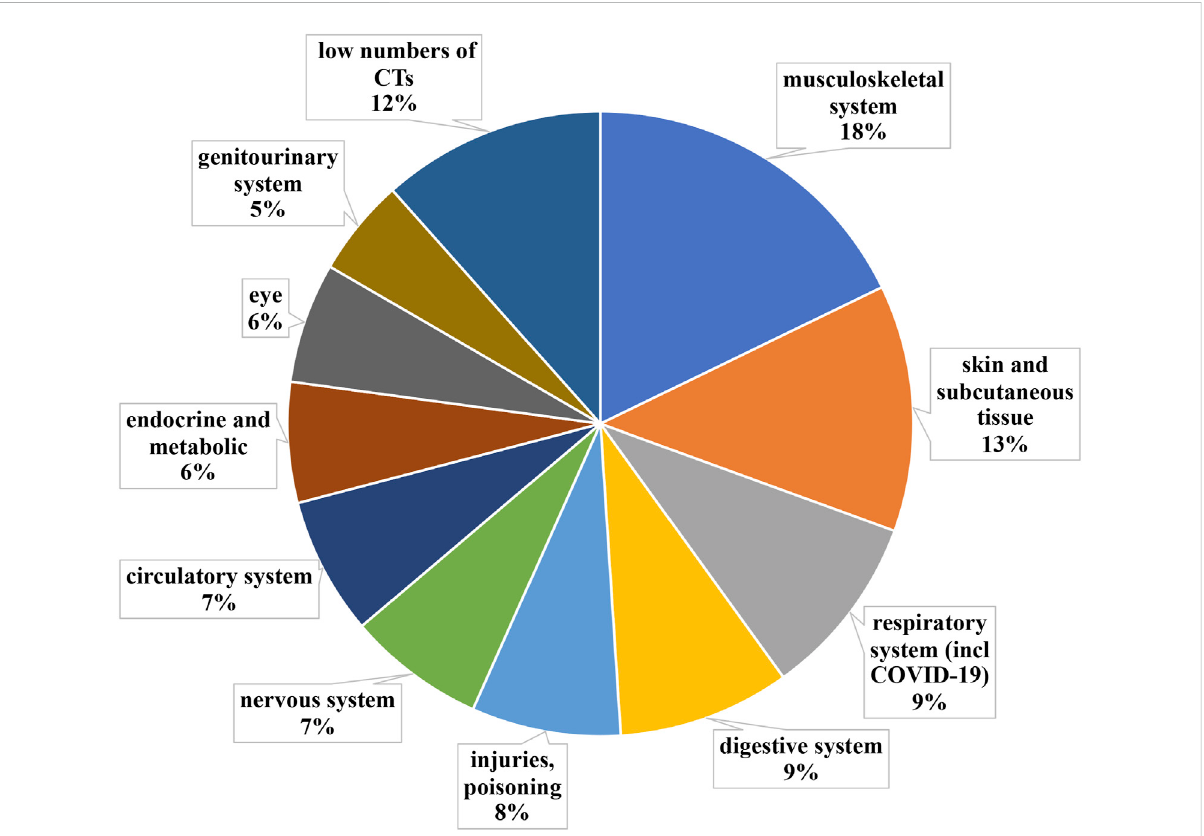
FIGURE 4 Groupingaccordingtomedical fi eldsICD-10classi fi cationofclinicaltrialsimplementingPnD.Medical fi eldswithlessthan10clinicaltrialswere grouped into “ medical fi elds with low number of clinical trials ” . The clinical trials using PnD for COVID-19 were classi fi ed as a respiratory system disease despite ICD-10 classi fi cation into “ special purposes ”